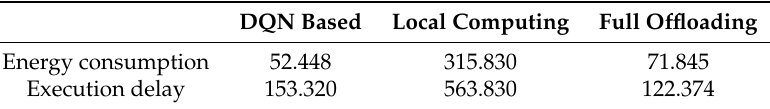
Figure 6. Performance evaluation results (comparison among DQN-based, full offloading, and local offloading): execution delay ( left ) and energy consumption ( right ). Table 2. Energy consumption and latency values with 10,000